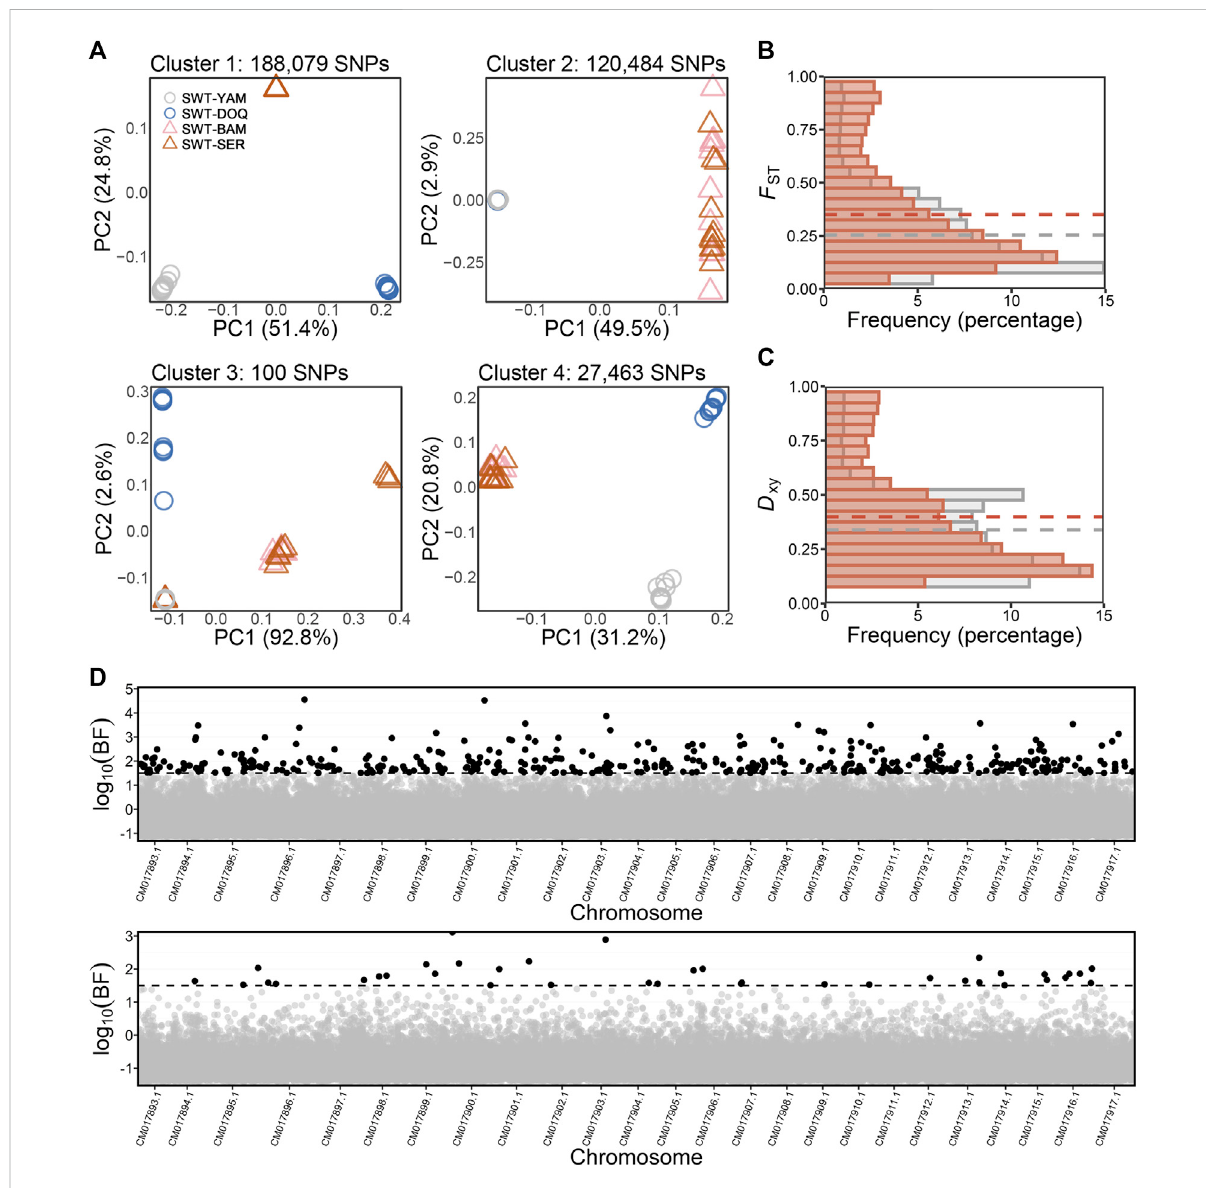
FIGURE 2 (A) PCAofgenome-wideSNPclustersidenti fi edusingtheLDgraphlearningmethodinallfourpopulationsof T.stewarti ,withcluster2showing thepattern of parallel adaptation to salinity between high- (triangles) and mid-salinity(circles) groups. (B,C) Distributions of fi xation index F ST (B) and absolute population differentiation D xy (C) of SNPs in genome-wide SNP cluster 2 (red bars) compared with all SNPs (gray bars) between high- and mid-salinity groups. Red and gray dash lines represent the average F ST / D xy of SNPs in genome-wide SNP cluster 2 and F ST / D xy of all SNPs, respectively. (D) Environmental association analysis of T. stewarti (upper panel) and T. stenura (lower panel). SNPs with a Bayesian factor above the threshold (log 10 (BF) = 1.5, dash line) are colored in